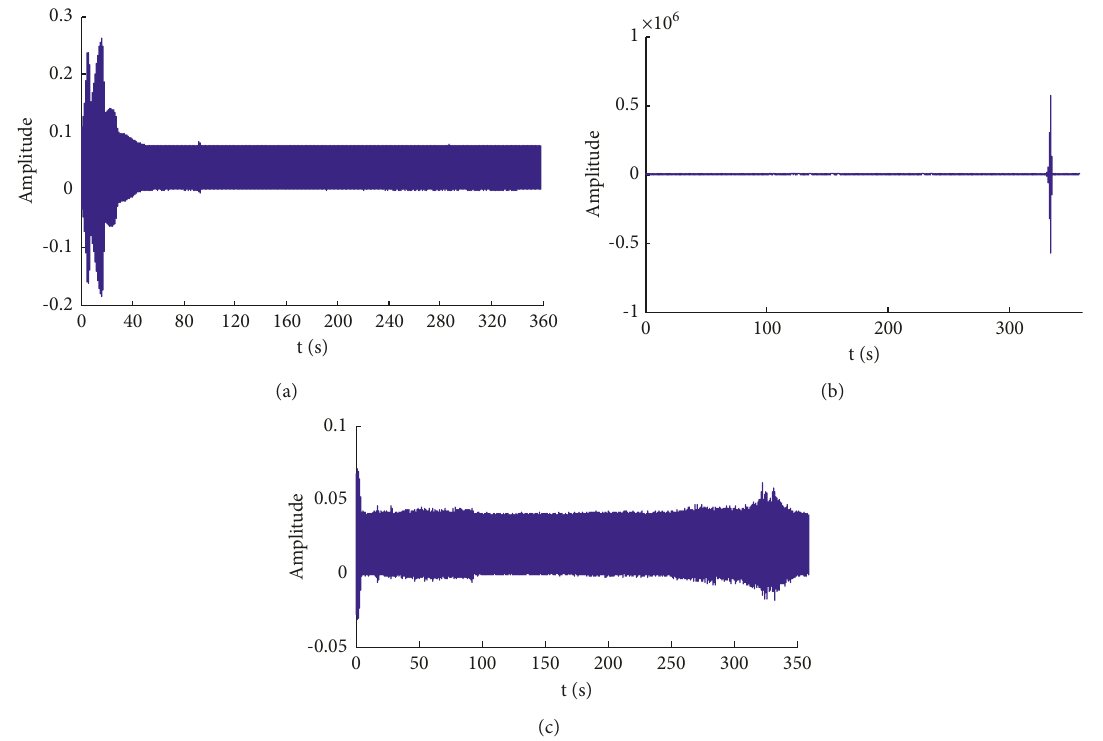
Figure 11: The curve of the error signal changing with time. (a) Normalization algorithm. (b) Sinusoidal variable step-size algorithm. (c) The improved